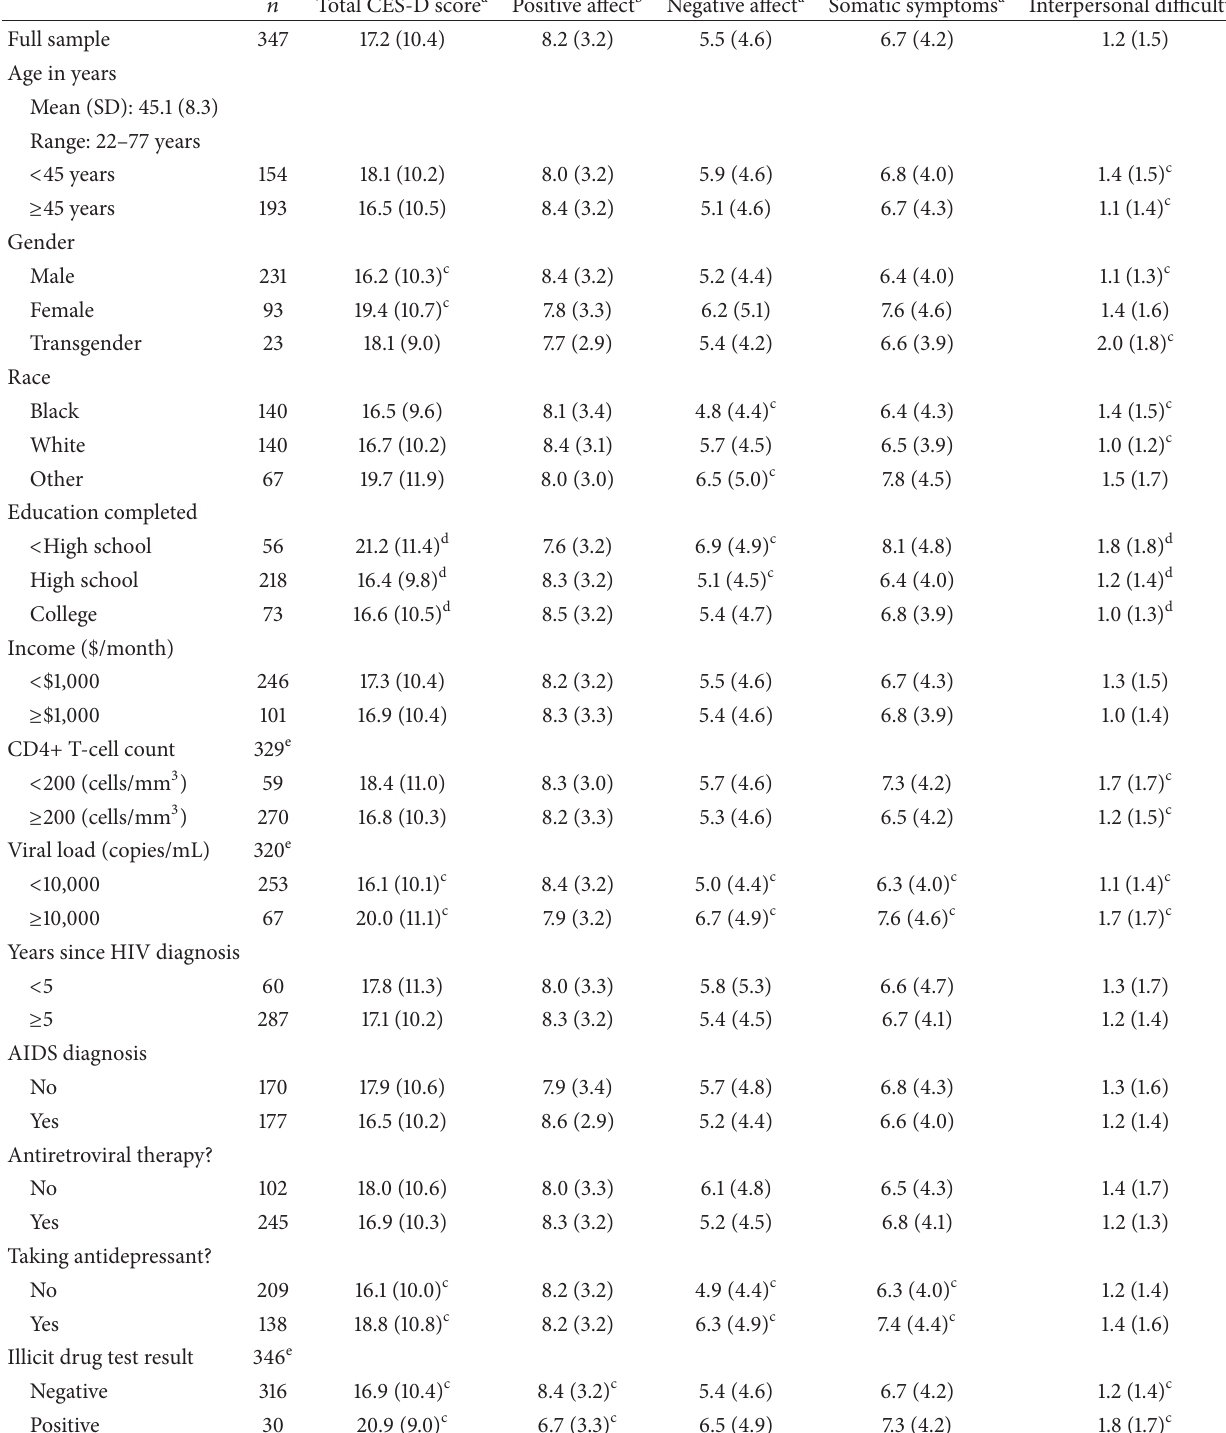
Table 2: CES-D scores by demographic and clinical characteristics, 𝑀